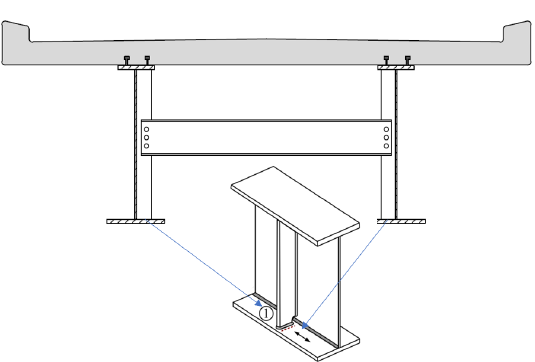
Figure 20. Cross-section of the road bridge girders, the concrete deck, and the transverse detail under study. Figure adapted from [17].